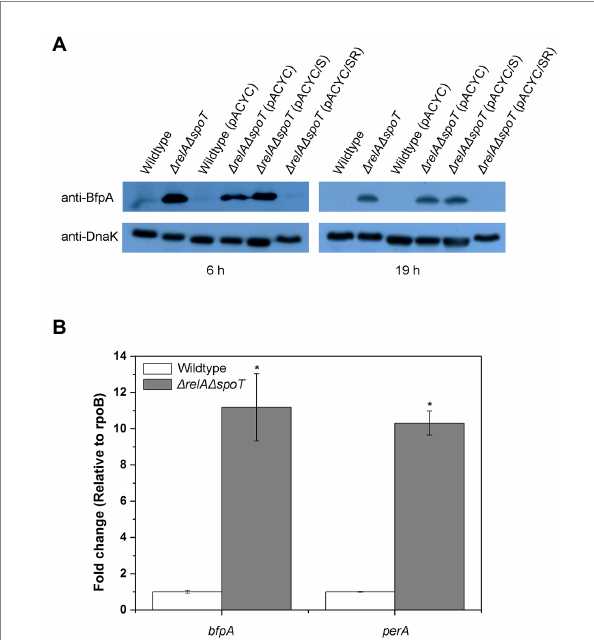
FIGURE 3 Derepression of type IV bundlin in the Δ relA Δ spoT EPEC. Wildtype and mutant strains grown in Luria-Bertani (LB) at 37 ° C for 18 h were diluted with pre-warmed LB and further incubated at 37 ° C for 6 or 19 h. (A) Equal amounts (200 μ g) of proteins were obtained from each strain and analyzed by western blotting to detect bundlin. DnaK was used as an internal control. Wildtype, E2348/69 strain; Δ relA Δ spoT , E2348/69 Δ relA Δ spoT mutant; wildtype (pACYC), E2348/69 carrying pACYC184; Δ relA Δ spoT (pACYC), E2348/69 Δ relA Δ spoT carrying pACYC184; Δ relA Δ spoT (pACYC/S), E2348/69 Δ relA Δ spoT carrying pACYC/S; Δ relA Δ spoT (pACYC/SR), E2348/69 Δ relA Δ spoT carrying pACYC/SR. (B) Expression patterns of bfpA and perA were analyzed by quantitative real-time PCR. Values are presented as mean ± standard error of the mean ( n = 3). Statistical significance was obtained by Student’s t -test (* p < 0.05).